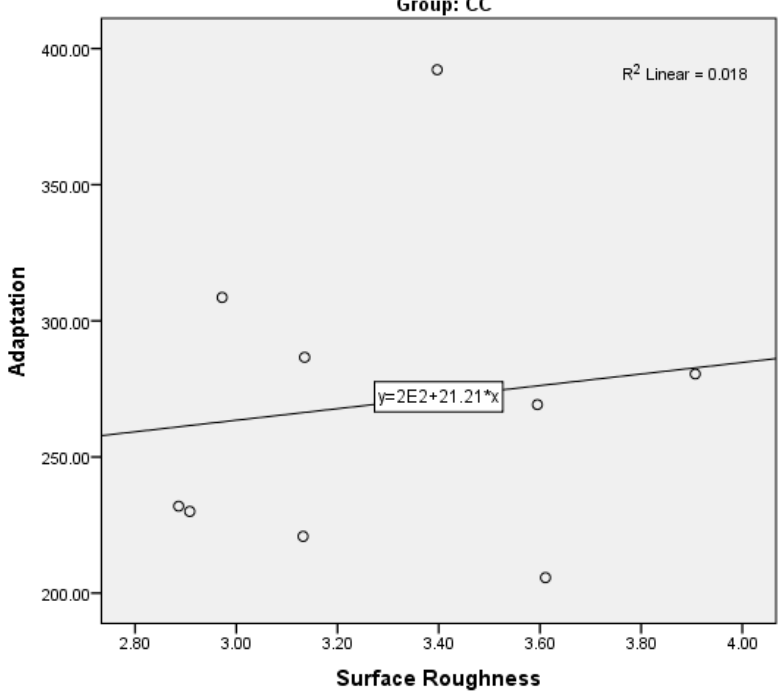
Figure 8. Scatter plot for the correlation between adaptation and surface roughness for the CC samples.